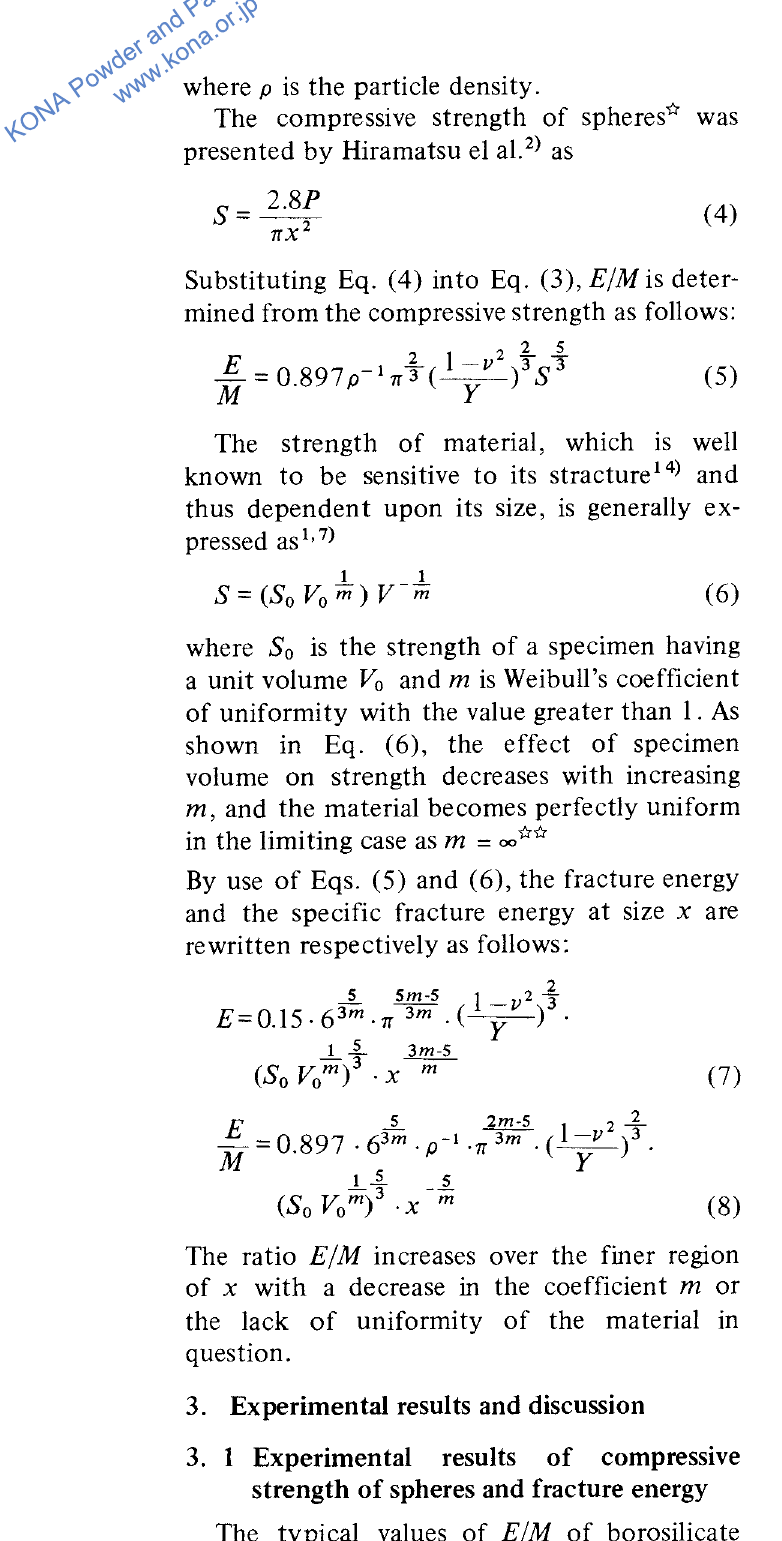
Fig. 2 Relationships between strength S and specific fracture energy E/M